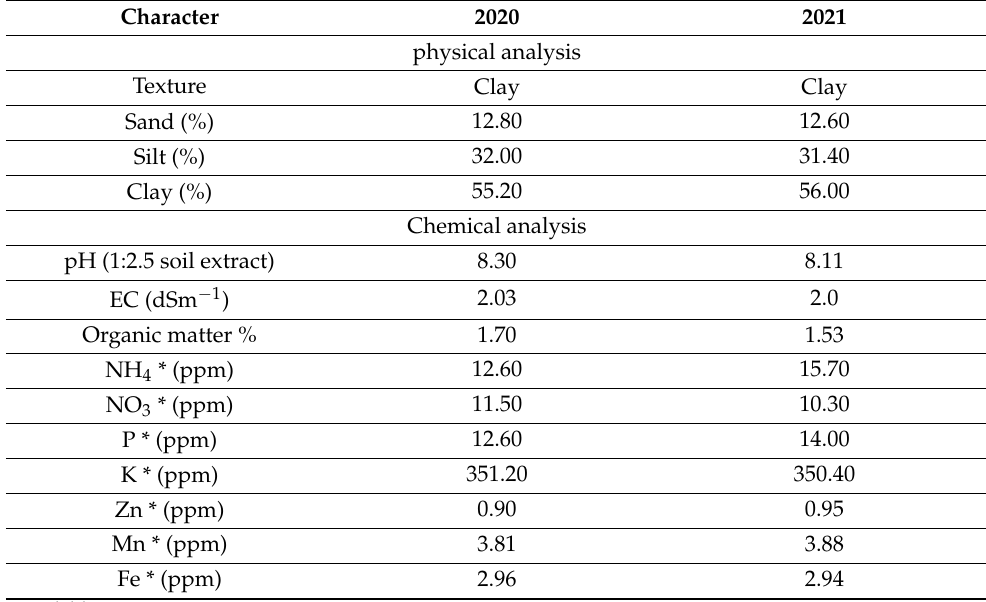
Table 2. The initial physiochemical traits of the soil samples during the 2020 and 2021 seasons.